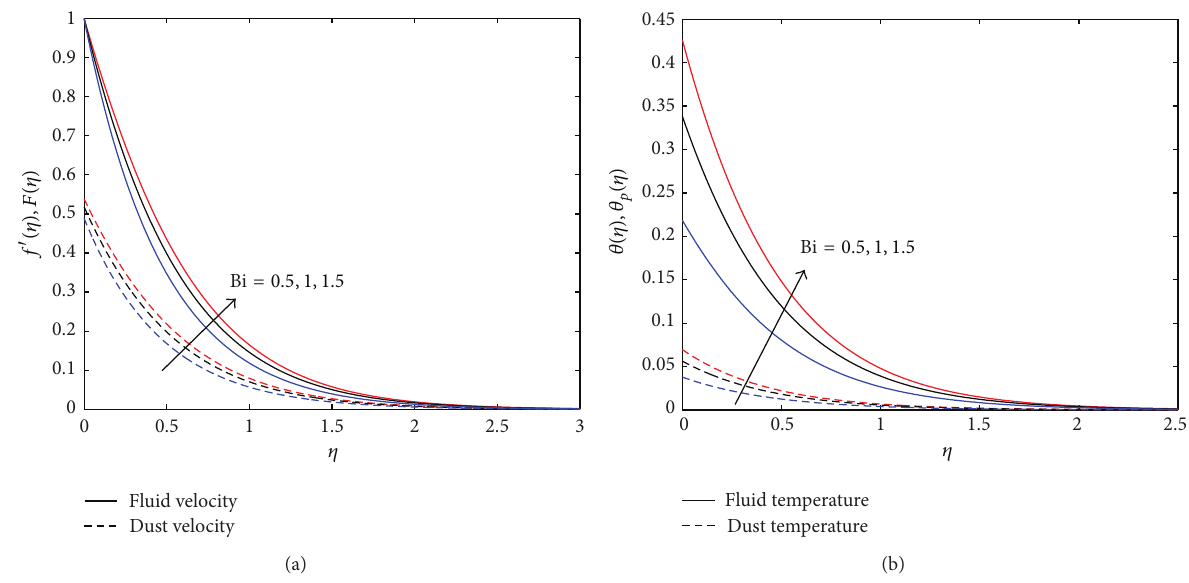
Figure 5: Effect of Bi on (a) 𝑓 󸀠 , 𝐹 and (b) 𝜃 , 𝜃 𝑝 when 𝑀 = 1 , 𝑆 = 2 , 𝑁 = 1 , 𝛽 ℎ = 1 , and Ec = 0.1